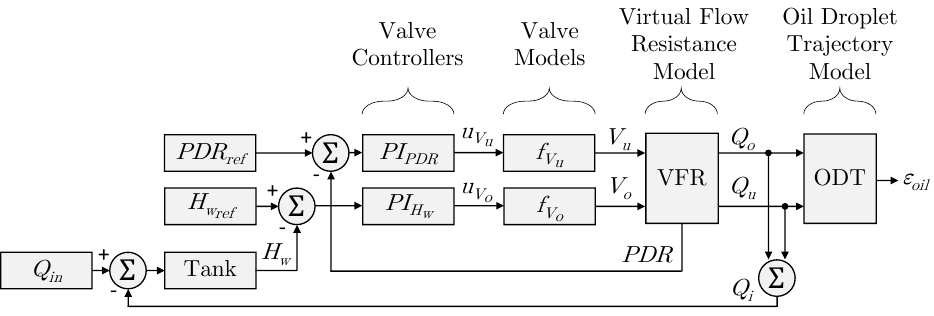
Figure 2. Overview of the model framework. The flow rate of water entering the separator tank ( Q in ) is a non-controllable input. The flow rate leaving the separator tank is the same flow rate that enters the hydrocyclone ( Q i ). The opening degree of the underflow valve ( V u ) is actuated by the water